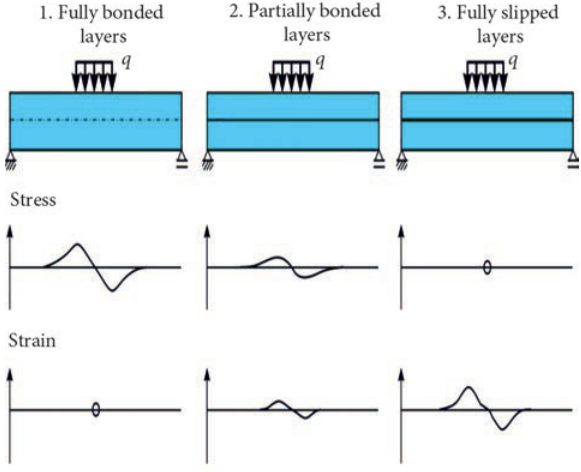
Fig. 1. Distribution of shear stresses and deformations (displacements) depending on the bonding level between the layers (Frohmut et al.